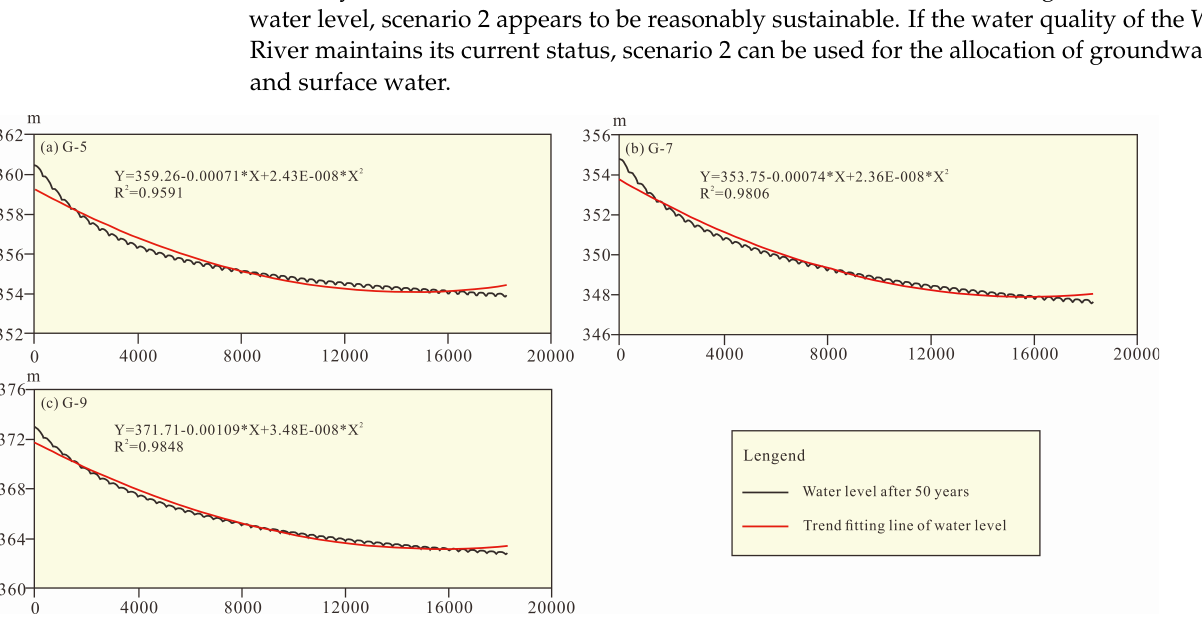
Figure 9. Maps showing the trend in change in water level of ( a ) G-5, ( b ) G-7, and ( c ) G-9 observation well for scenario